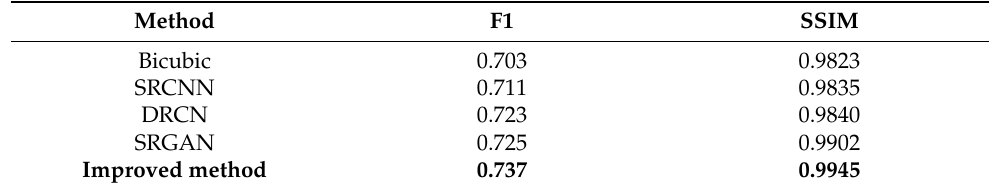
Table 7. Comparison of crack segmentation F1 value and SSIM value of different methods.